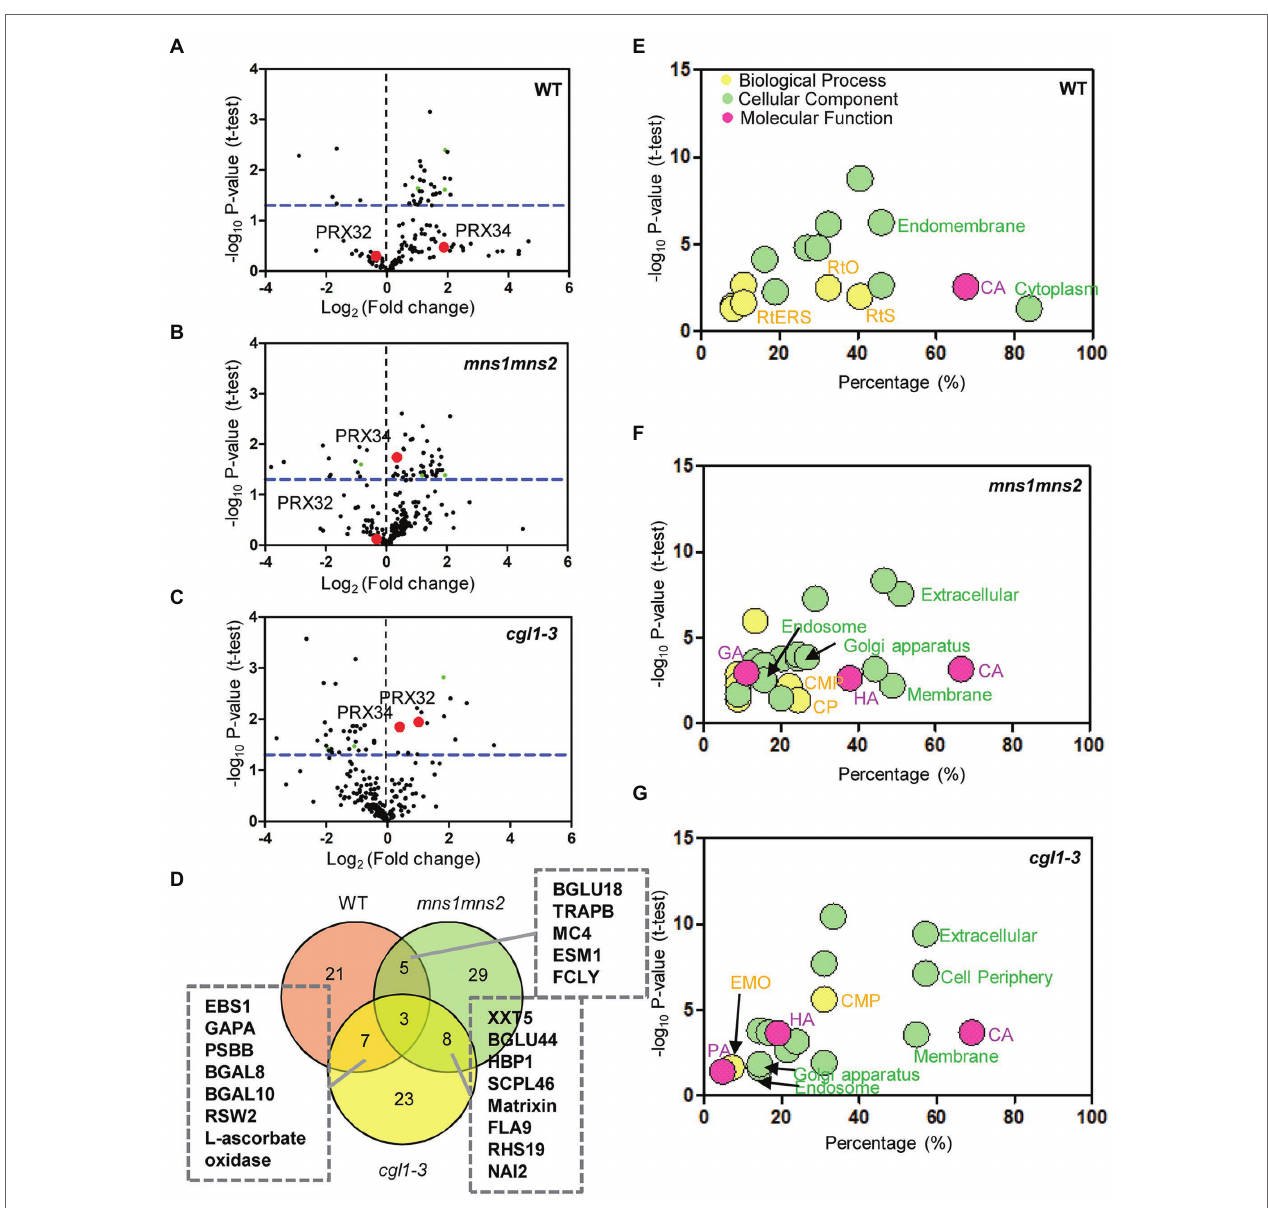
FIGURE 3 | Gene ontology (GO) annotations of differentially abundant N-glycoproteins under salt stress. (A–C) Identification of differentially abundant N-glycoproteins in the WT (A) , mns1 mns2 (B) , and cgl1-3 (C) under salt stress. Each dot represents one protein. The blue horizontal bar represents the threshold value of p ( ≤ 0.05). The red dots represent PRX32 and PRX34. (D) Venn diagram demonstrating the overlap in the number of salt stress-responsive glycoproteins in the WT, mns1 mns2 , and cgl1-3 . Three common proteins quantified in the WT and two mutants are presented as green dots in (A–C) . (E–G) GO analyses of salt stress-responsive proteins in the WT (E) , mns1 mns2 (F) , and cgl1-3 (G) . Significantly enriched GO terms are marked on the diagram. CA, catalytic activity; HA, hydrolase activity; PA, phosphorylating activity; GA, glucosidase activity; RtO, response to organic substance; RtS, response to stress; RtERS, response to ER stress; CMP, carbohydrate metabolic process; CP, catabolic process; EMO, extracellular matrix